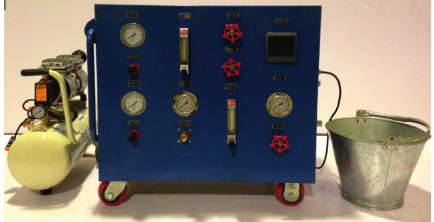
Figure 3: Image of foam